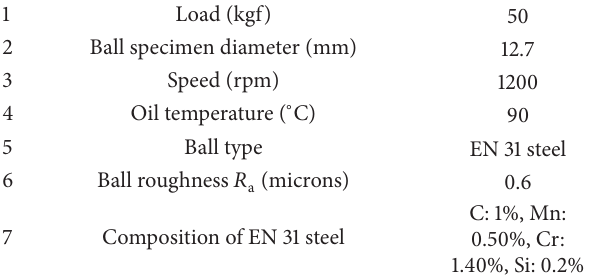
Table 1: Test operating conditions of four-ball test rig.